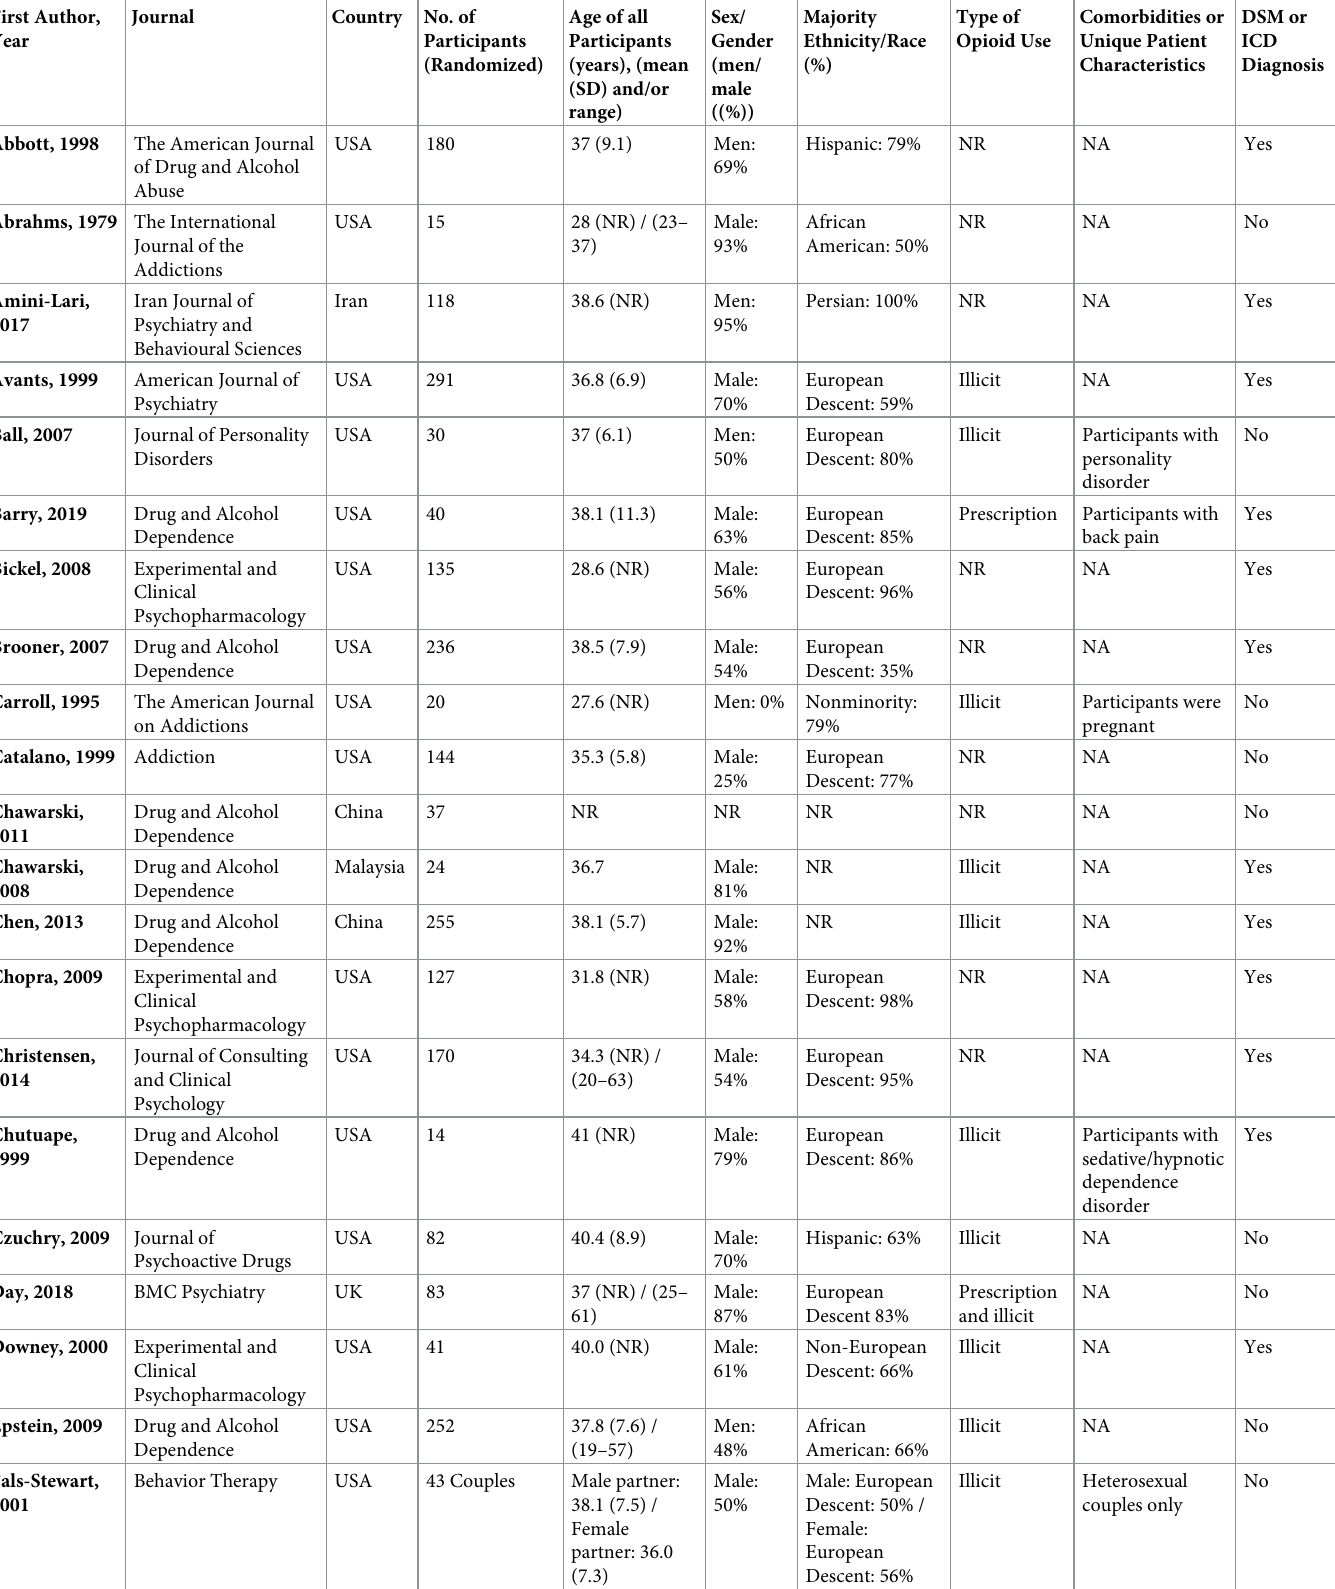
Table 1. Overview of included